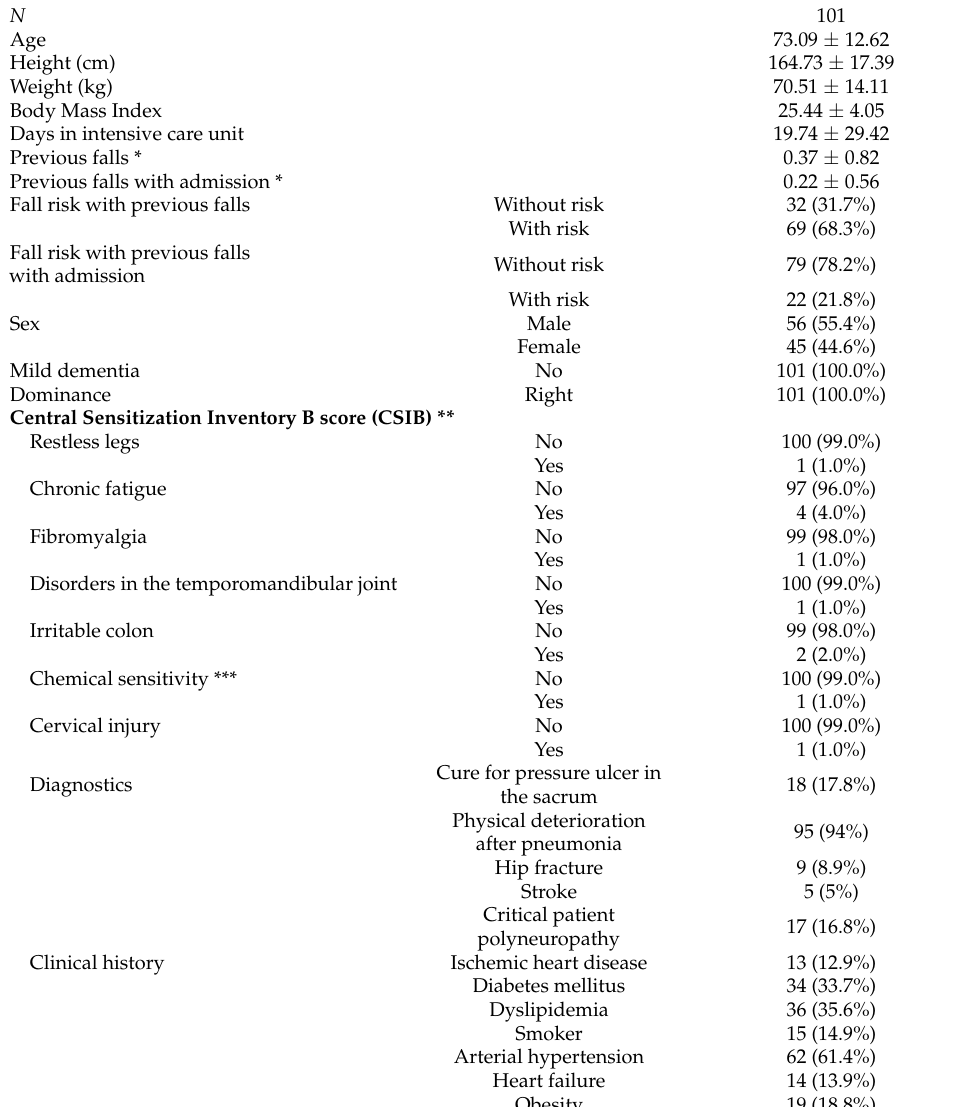
Table 1. Patients’ baseline demographic and clinical